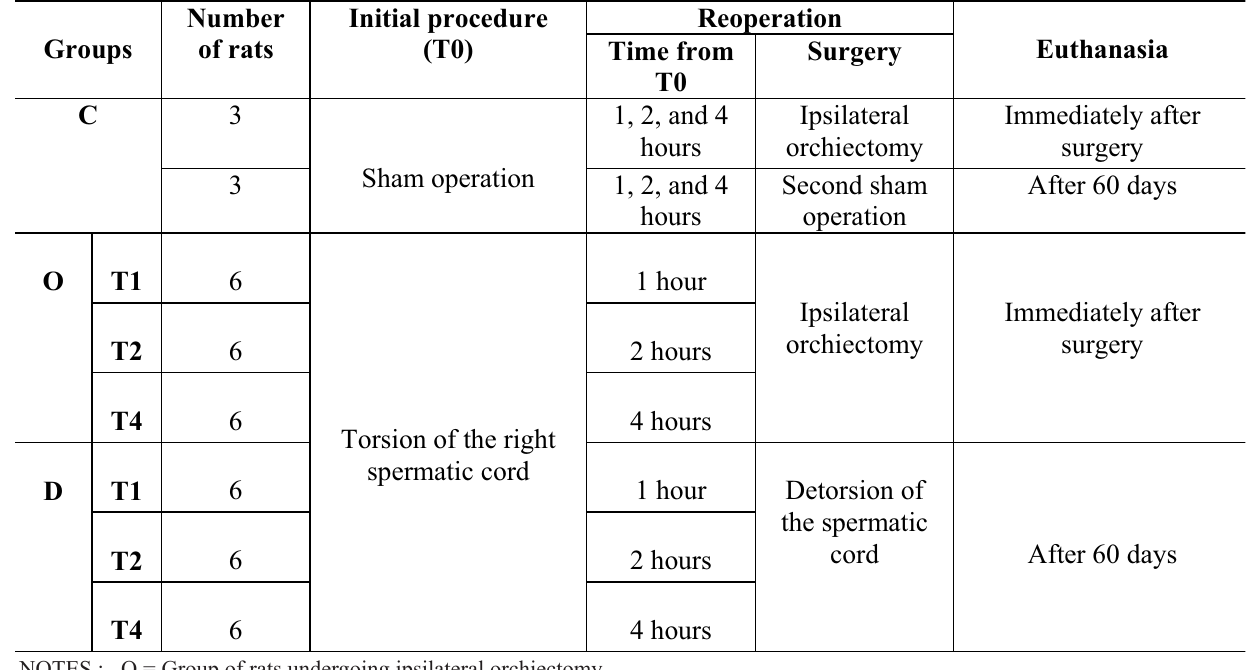
TABLE 1 – Study design and groups of